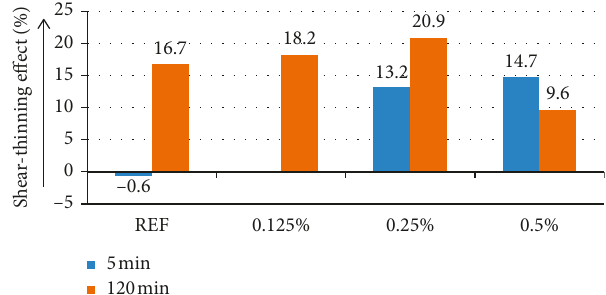
Figure 14: Shear-thinning behavior of nanomodified cement pastes within 5 and 120min duration.